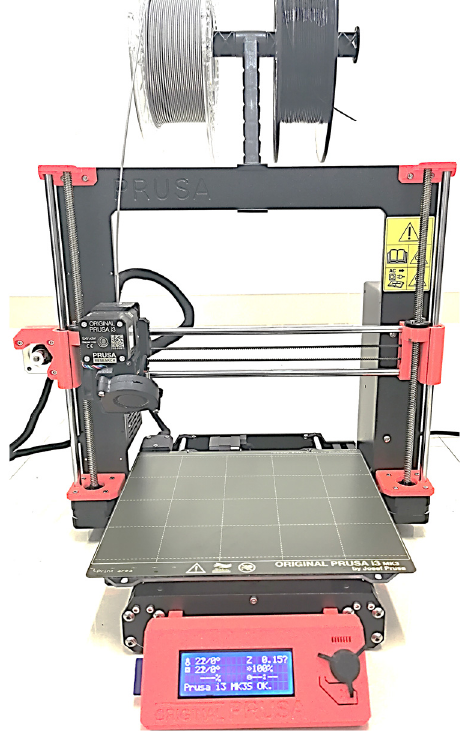
Figure 2. FFF 3D printer.